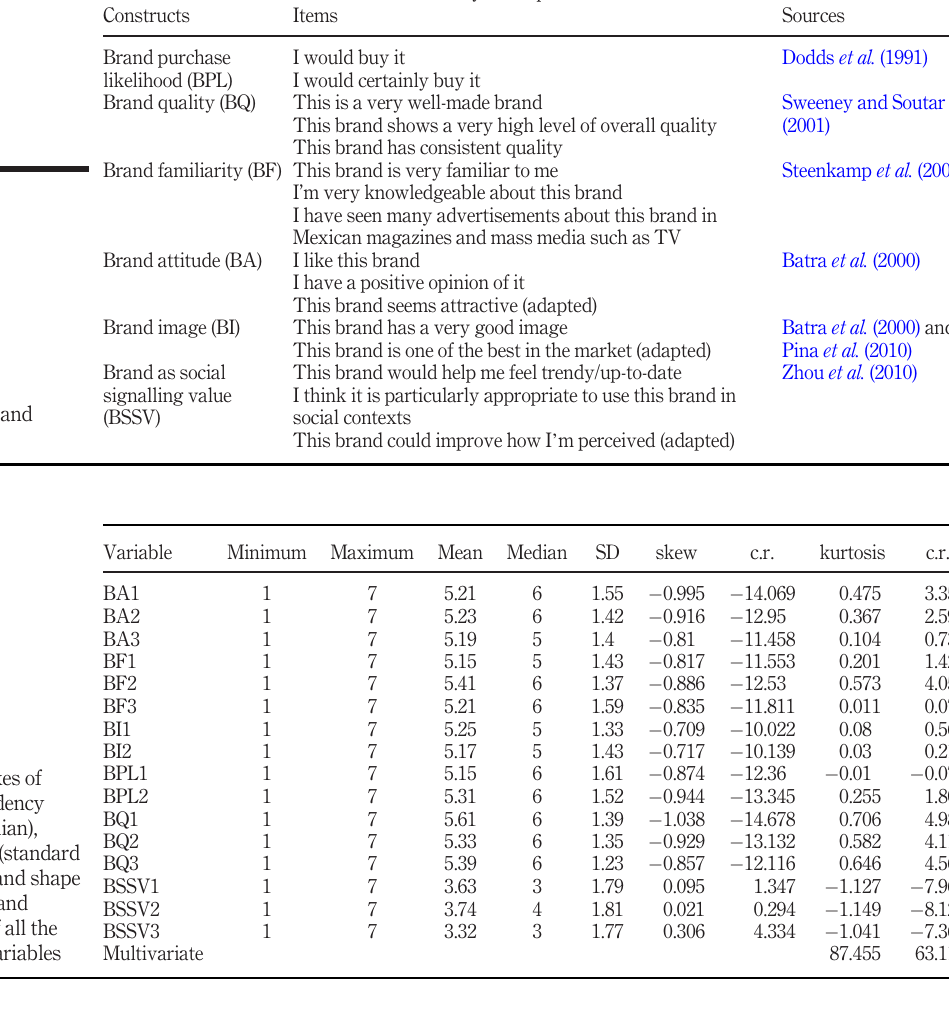
indices of central tendency (mean, median), variability (standard deviation) and shape (skewness and kurtosis) of all the manifest variables. To test the extent to which the distribution of each variable deviated from the desired values of symmetry and kurtosis (both coef fi cients are zero when a random variable follows a normal distribution), a univariate normality contrast based on skewness and kurtosis statistics together is provided. The results obtained show the departures from the normality distributional assumption. Furthermore, as most of the hypothesized relationships have been previously under-investigated in the literature, PLS-SEM is an adequate procedure for analysing the model hypothesized in this study. SmartPLS 3.0 software was used to analyse the data